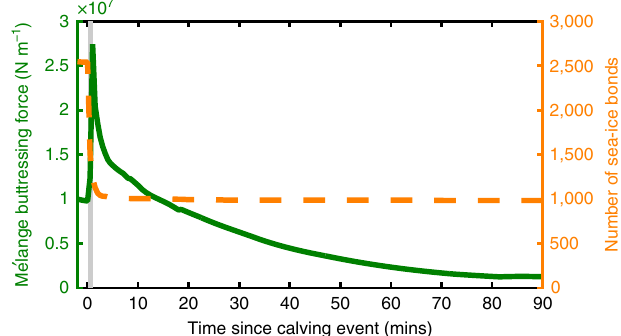
Figure 4 | Simulated response of me´lange with 2-m-thick sea ice to a calving event. Green solid line is me´lange buttressing force (averaged over terminus width and not including calving iceberg). Orange dashed line is the number of sea-ice bonds as a function of time following calving